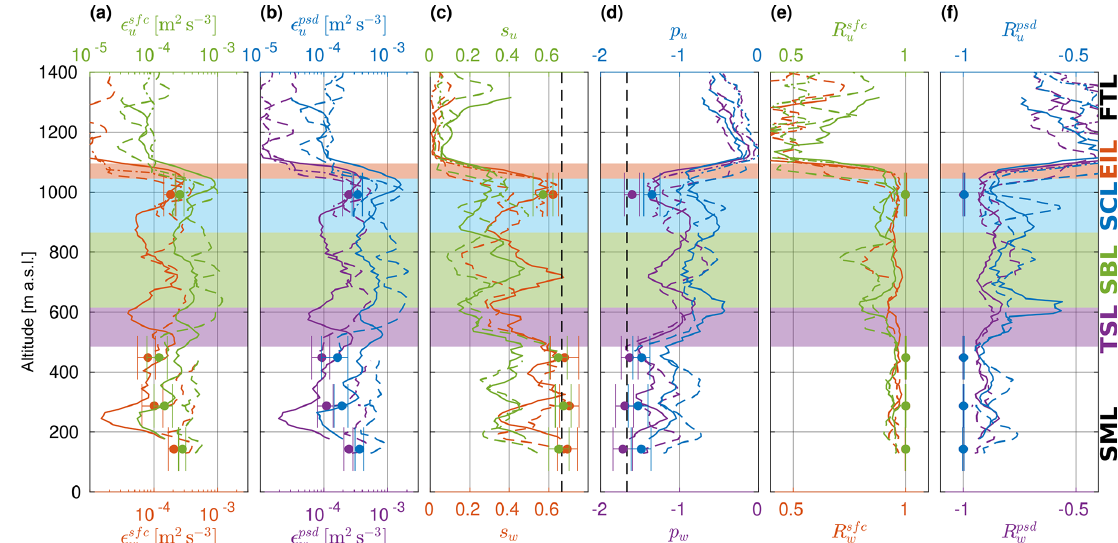
Figure 14. As in Fig. 13 but for the decoupled STBL (flight no. 14).